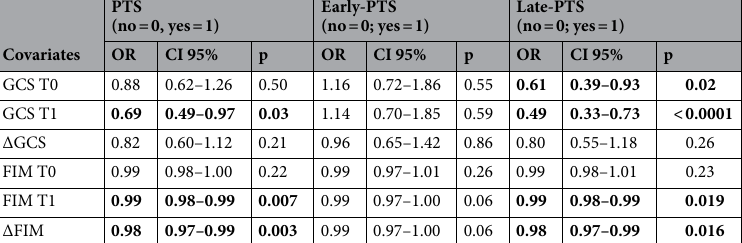
Table 3. Association between presence of post-traumatic seizures (PTS) and neurological or rehabilitation outcome, respectively measured with the Glasgow Coma Scale (GCS) and the Functional Independence Measure (FIM) at 6 months from traumatic brain injury . Odds ratios (OR) are given for the overall group of patients with PTS and for patients subdivided according to early (EPTS) vs. late PTS (LPTS). T0 on admission to neurorehabilitation, T1 at discharge. Significant difference are highlighted in bold.